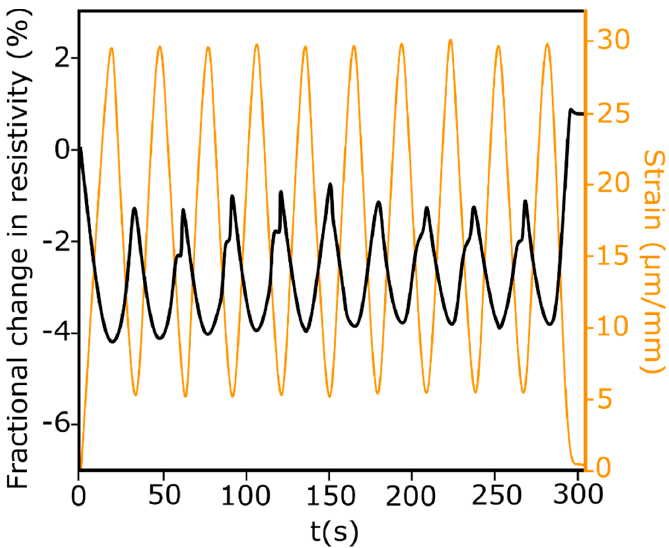
Figure 6. Fractional change in resistivity of slag AAM under cyclic flexural loading, example adapted from [51].